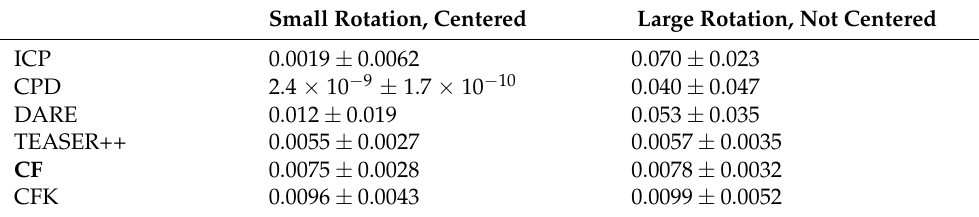
Table A1. Robustness test: smaller is better.